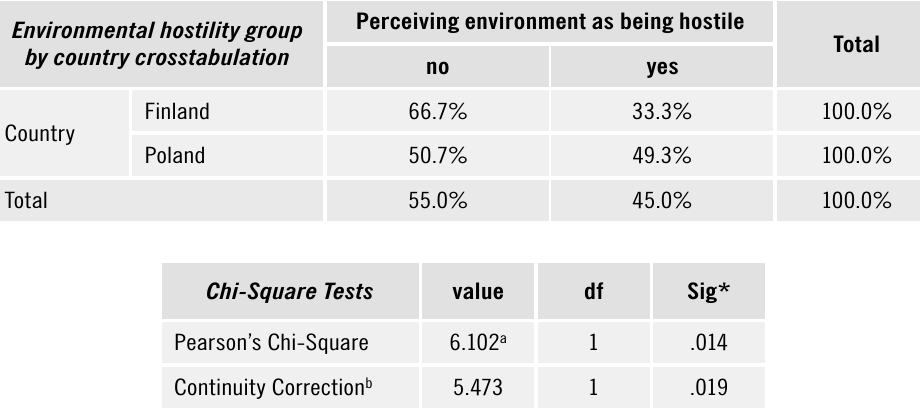
Table 5. Relationship between environmental hostility group and country Environmental hostility group by country crosstabulation